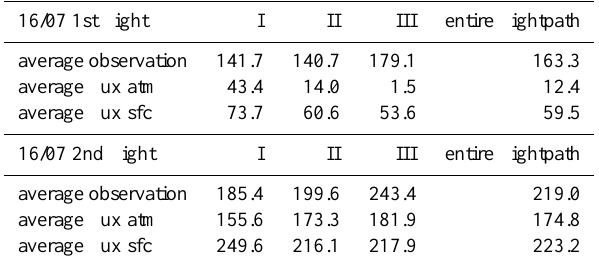
Table 5. Landscape averaged latent heat fluxes (Wm − 2 ) along the flightpath for both flights on 16 July 2002. The three landscapes (see text) are referred to according to their roman number in Fig. 3. flux atm represents the simulated flux at the same level as the flight- path, whereas flux sfc represents the simulated flux at the land sur- face below the